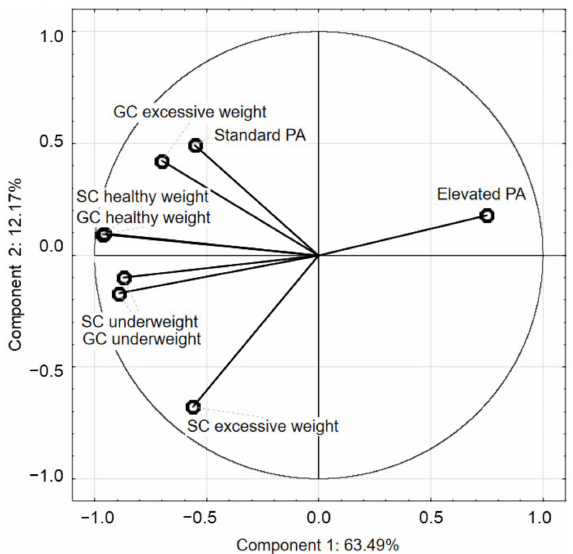
Figure 6. The PCA analysis of children’s body mass categories depending on the PA time at school.